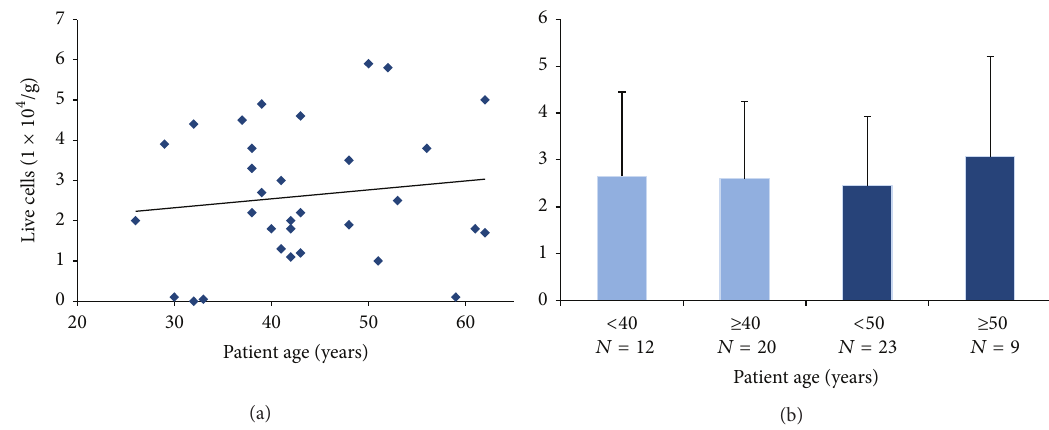
Figure 4: Live ASC isolation relative to patient age. (a) ASCs were isolated from 32 patients of different ages (range 26–62 years, average 43.2 ± 9.7 ). Live ASCs isolated ranged from 0 to 95. 5 × 1 0 4 cells/g adipose, average 63.8 ± 30.6 , with no clear correlation between ASC isolation and patient age. (b) Live cell count was compared relative to patient age across 4 cohort groups: < 40 years ( 𝑁 = 12 ) versus ≥ 40 years ( 𝑁 = 20 ); < 50 years ( 𝑁 = 23 ) versus ≥ 50 years ( 𝑁 = 9 ); and < 40 years ( 𝑁 = 12 ) versus ≥ 50 years ( 𝑁 = 9 ). No significant differences in live ASC isolation were observed between any of the age cohorts; 𝑃 > 0.05 .